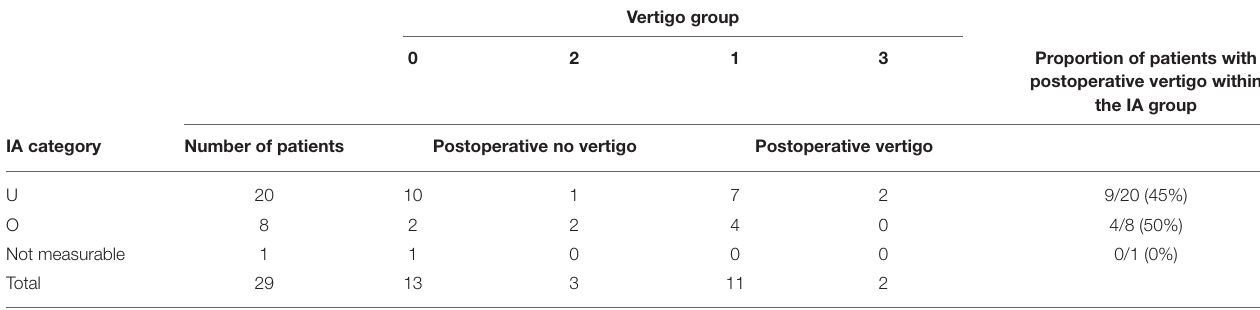
TABLE 8 | Relation of insertion angle category and vertigo group (for information on vertigo group, see Table 2 ).